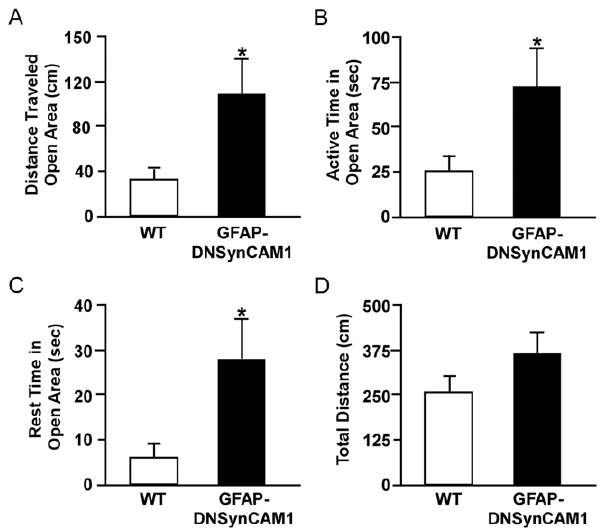
Figure 4. DN-SynCAM1 mice display behaviors of reduced anxiety in the zero maze. ( A ) Total distance traveled (cm) by GFAP- DNSynCAM1 (black bars; n=9) and WT littermates (white bars, n=8) in the open areas of the zero maze. ( B ) Total active time (seconds) in the open areas for GFAP-DNSynCAM1 (black bars) and WT littermates (white bars). ( C ) Total rest time (seconds) in the open areas for GFAP- DNSynCAM1 (black bars) and WT littermates (white bars). ( D ) Total distance traveled in the open and closed areas of the zero maze by GFAP-DNSynCAM1 (black bars) and WT littermates (white bars). Data are represented as the mean 6 SEM and compared using an unpaired t- test. * p , 0.05.